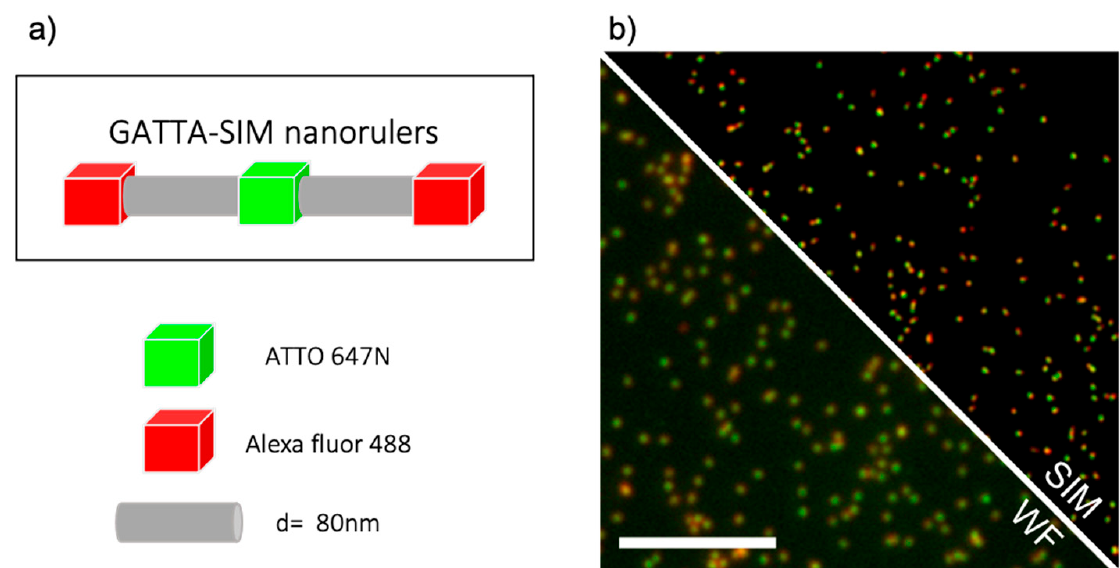
Figure 1. Schematic of the optical nanoruler and SIM imaging. ( a ) Schematic representation of GATTA-SIM nanorulers. Each nanoruler presents two groups of red fluorophores at both ends, ATTO 647N, and one central group of Alexa fluor 488 green fluorophores spaced from the two red ones by 80 nm. ( b ) Comparison between Widefield and N-SIM reconstructed image of GATTA-SIM nanorulers, ROI 256 × 256 pixels, scalebar 5 µm.